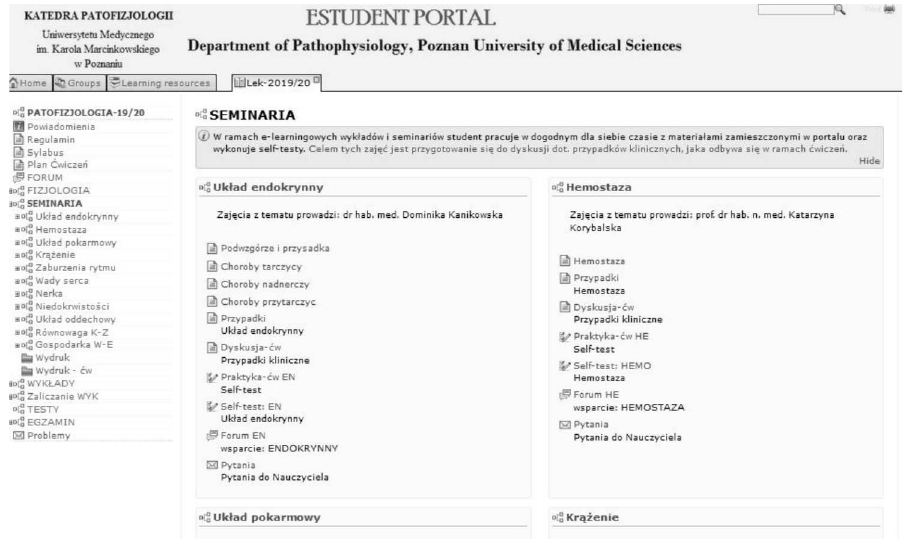
Figure 1. E-learning course in Pathophysiology for year 2 of Medicine studies